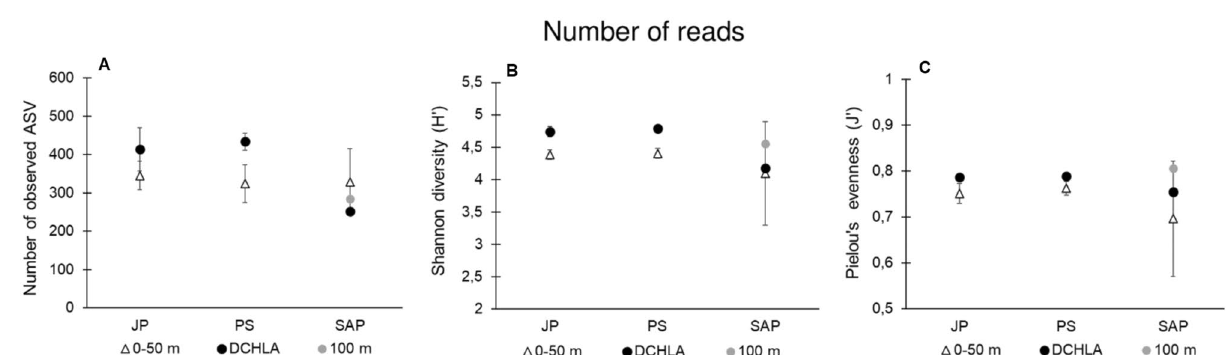
Figure 7. ( A ) Number of observed ASV. ( B ) Values of Shannon diversity index and ( C ) Values of Pielou’s evenness index at Jabuka Pit (JP), Palagruža Sill (PS) and South Adriatic Pit (SAP). Average values ± standard deviations (error bars) from layers are